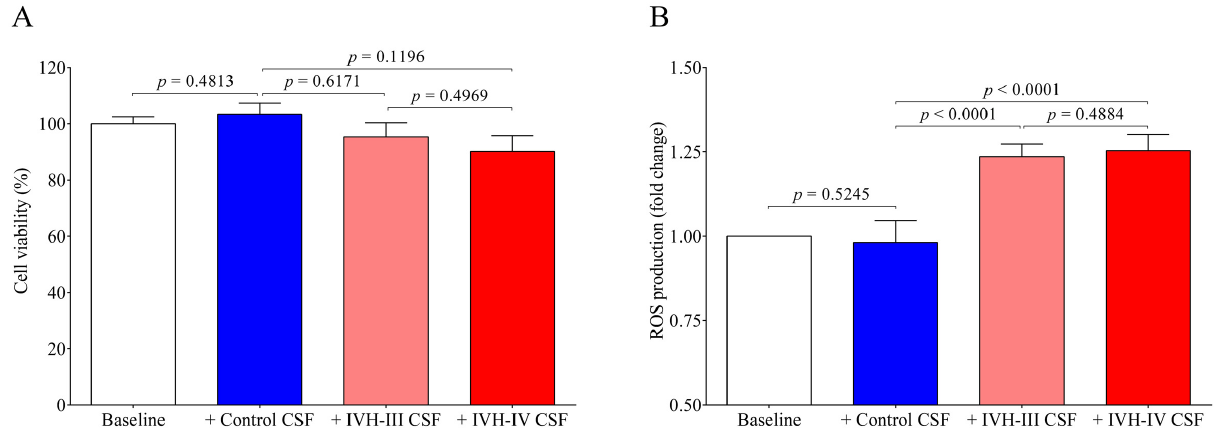
Figure 5. Cell viability test and the detection of ROS production induced by ex vivo CSF samples obtained from IVH-III (light red) patients, IVH-IV (red) patients, or non-IVH clinical controls (blue). In the cell viability assay ( A ), HCPEpiCs were treated with ex vivo CSF samples (10 v / v %) for 24 h, followed by an MTT-based cell viability test. Results were shown as a percentage of viability of vehicle-treated (baseline, clear column) cells. (B) Confluent HCPEpiCs were exposed to vehicle non-IVH CSF, IVH-III, or IVH-IV CSF samples (10 v / v %) for 4 h and ROS production was measured after every 30 min using the CM-H2DCFDA assay for 3 h. The graphs show the ROS production at the 60 min time point expressed in fold change ( B ). Mean ± SEM values are depicted, n = 7–8/group. The ANOVA test with Bonferroni’s multiple comparison test was used for the comparisons. Abbreviations: CSF, cerebrospinal fluid; CM-H2DCFDA, General Oxidative Stress Indicator assay; HCPEpiCs, human choroid plexus epithelial cells; IVH, intraventricular hemorrhage; MTT, Thiazolyl Blue Tetrazolium Bromide; and ROS, reactive oxygen